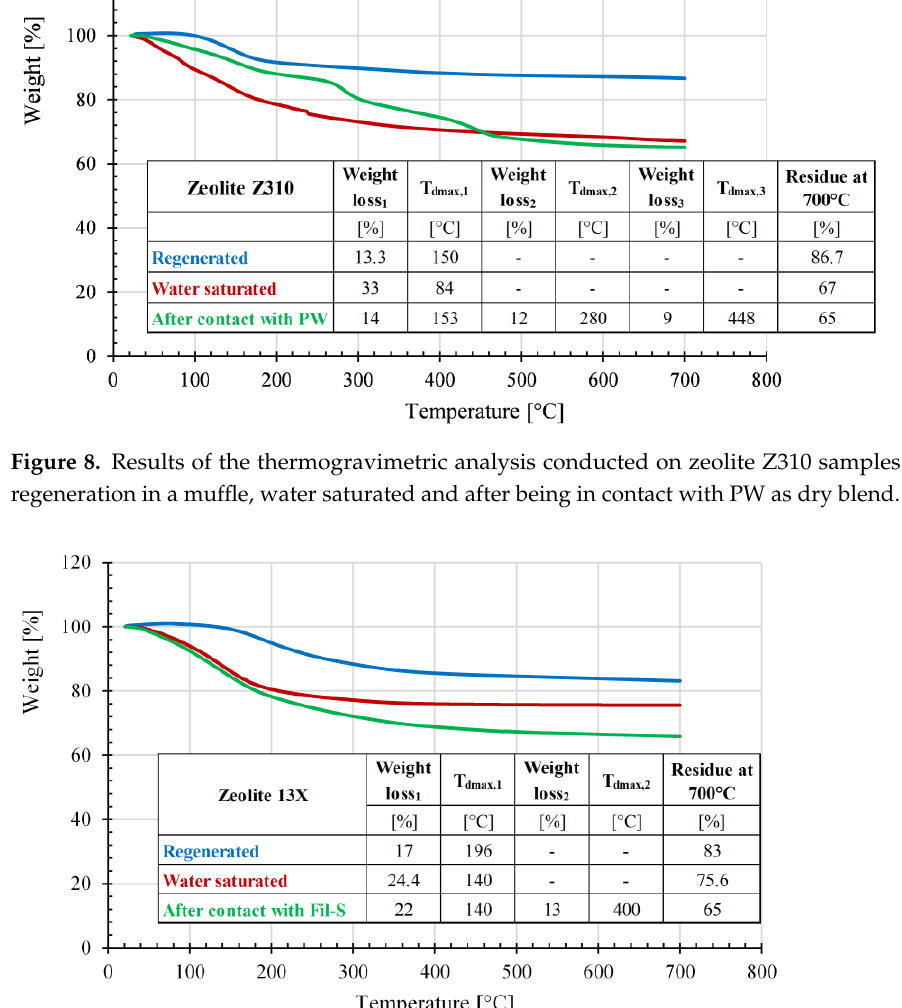
Figure 9. Results of the thermogravimetric analysis conducted on zeolite 13X samples: after its regeneration in a muffle, water saturated and after contact with Fil-S as dry blend.